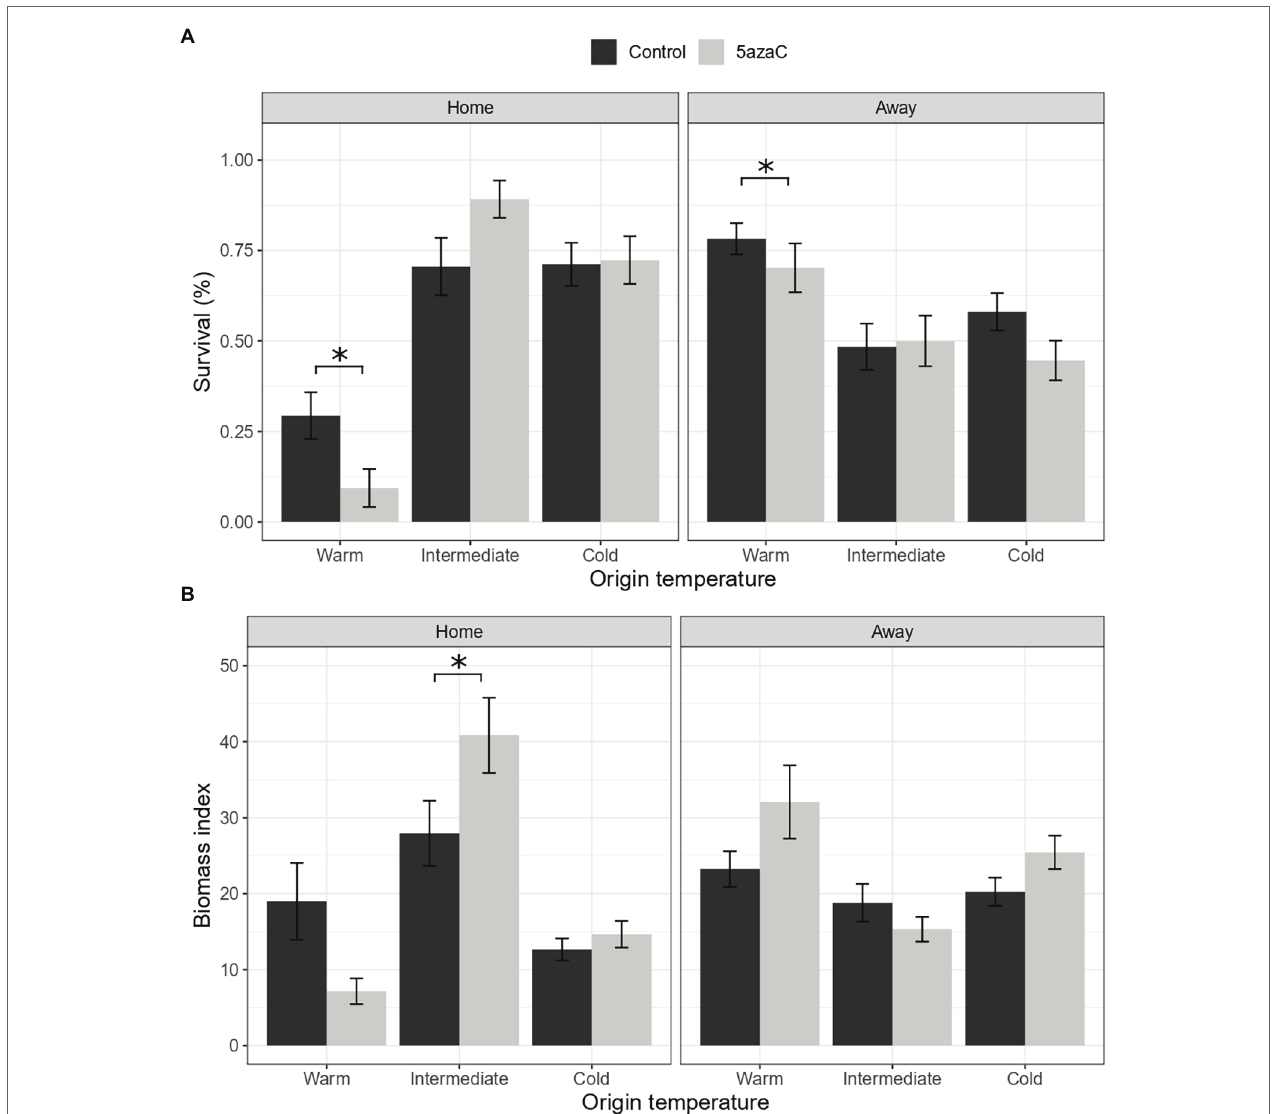
FIGURE 2 | Is local adaptation mediated by DNA methylation (Hypothesis 2)? Effects of origin temperature, home/away site and 5-azaC on plant survival (A) and biomass (B) . Home: plants in their home site, away: plants in away sites. Control: plants with natural DNA methylation, 5azaC: plants treated with 5-azaC. Values represent the means ± 1 standard error (SE). Significance level p < 0.05 ( *